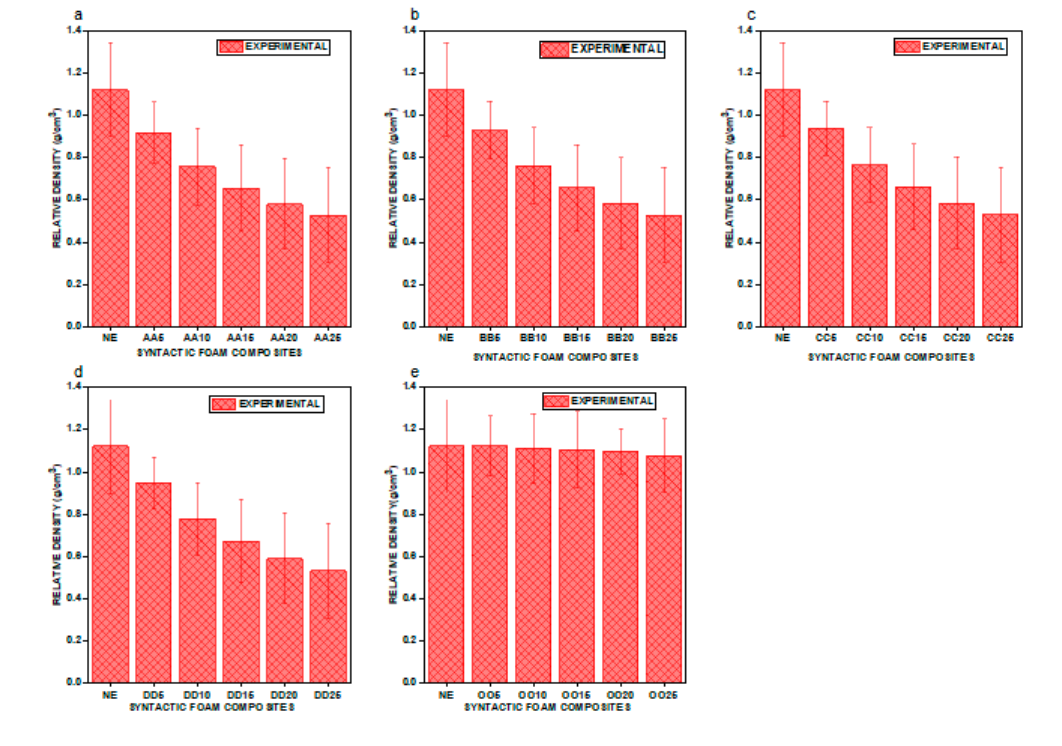
Figure 3. Graphical representation of density for ( a ) NE vs. AA5, AA10, AA15, AA20, and AA25; ( b ) NE vs. BB5, BB10, BB15, BB20, and BB25; ( c ) NE vs. CC5, CC10, CC15, CC20, and CC25; ( d ) NE vs. DD5, DD10, DD15, DD20, and D25; ( e ) NE vs. OO5, OO10, OO15, OO20, and OO25.